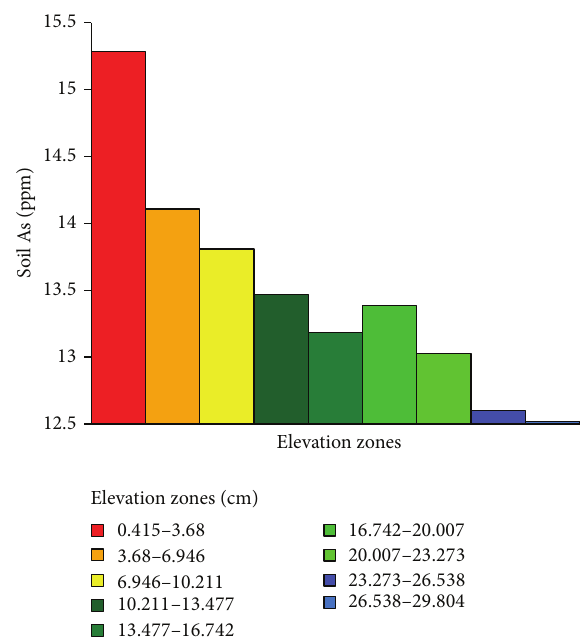
Figure 10: Soil As summarized within the zones of elevation.